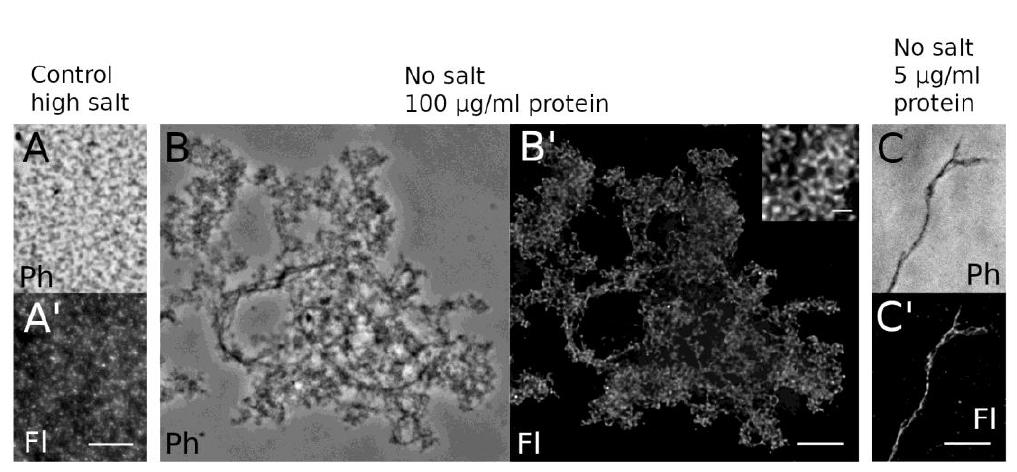
Figure 6. Light microscopy reveals reticular HisMyc-NE81ΔNLSΔCLIM assemblies. Purified protein was fixed with formaldehyde and stained with anti-NE81/anti-rabbit-AlexaFluor 488. Phase-contrast ( A – C ; Ph) and fluorescence images ( A – C′ ; Fl) are shown. ( A , A′ ) At high NaCl concentration, no clear assemblies are visible, whereas the protein forms reticular assemblies at no-salt conditions and high protein concentration ( B , B′ ). At low protein concentration ( C , C′ ), individual filamentous structures become apparent. Scale bars = 5 µm (inset = 1 µm).